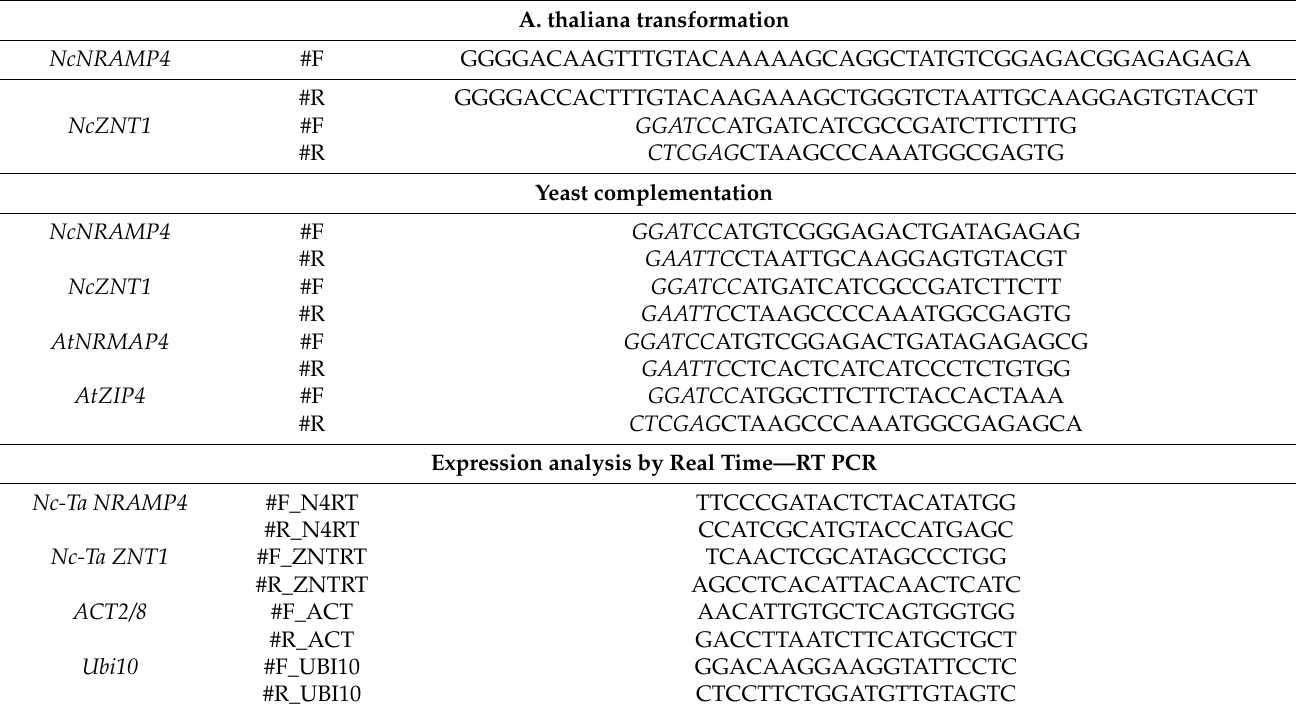
Table 2. Primers utilized to amplify NRAMP4 and ZNT1—ZIP4. See Material and Methods for